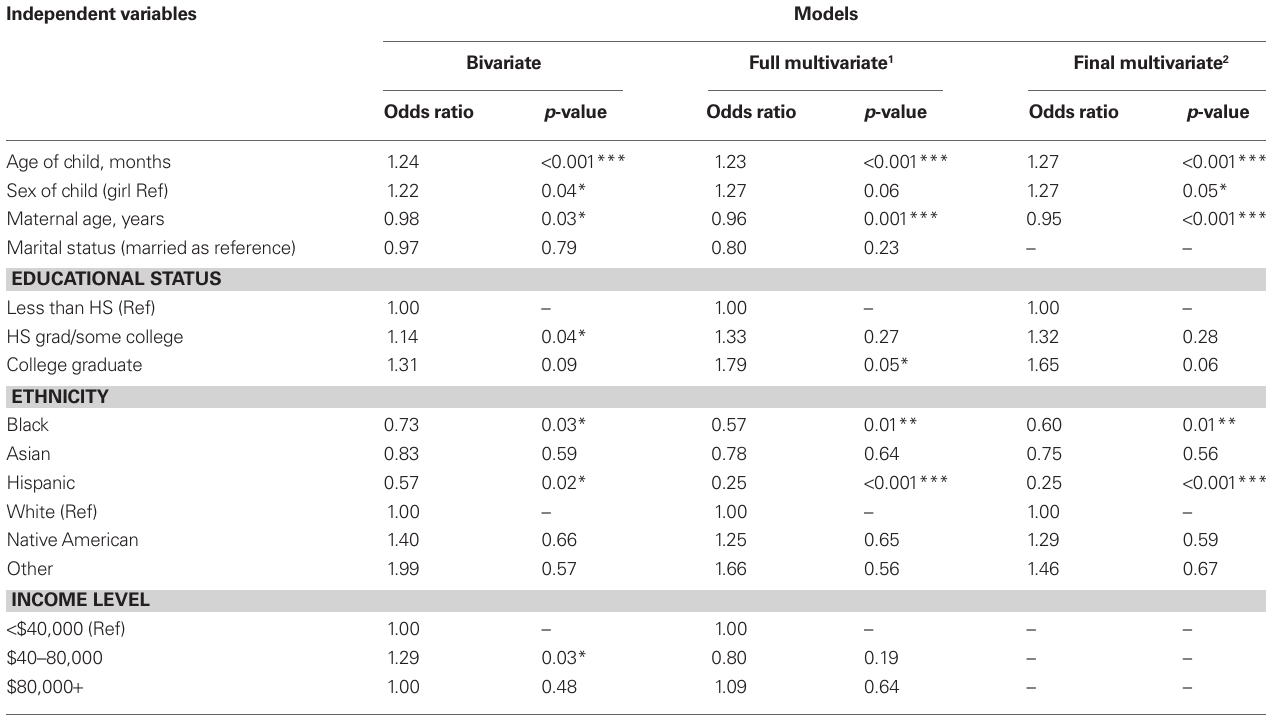
Table 3 | logistic regression models of spanking behavior on maternal characteristics ( N = 2790).